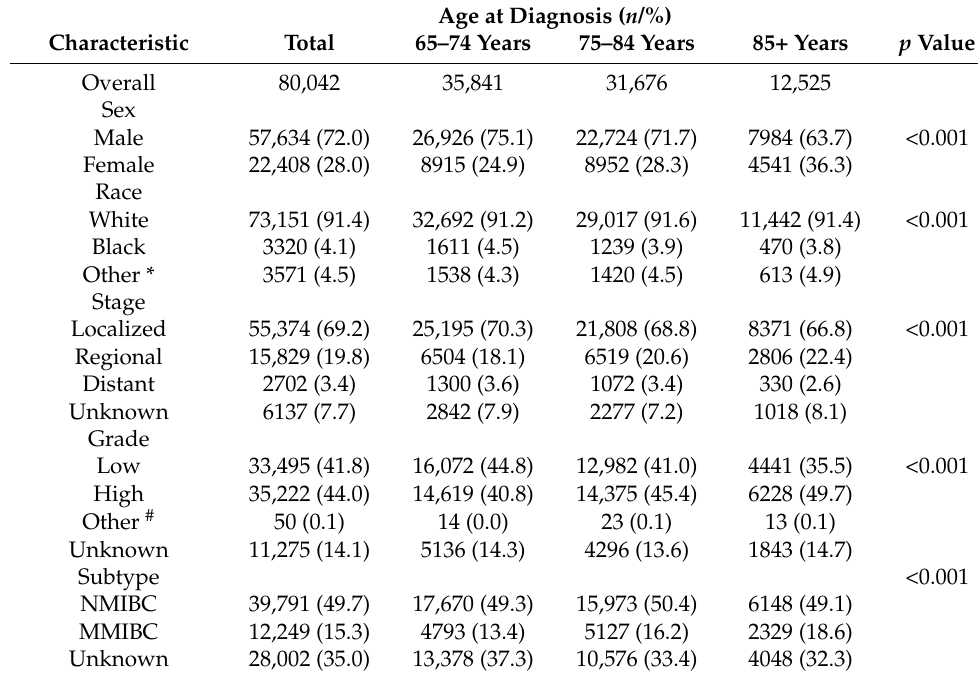
Table 1. Baseline characteristics of elderly patients with bladder cancer. Age at Diagnosis ( n